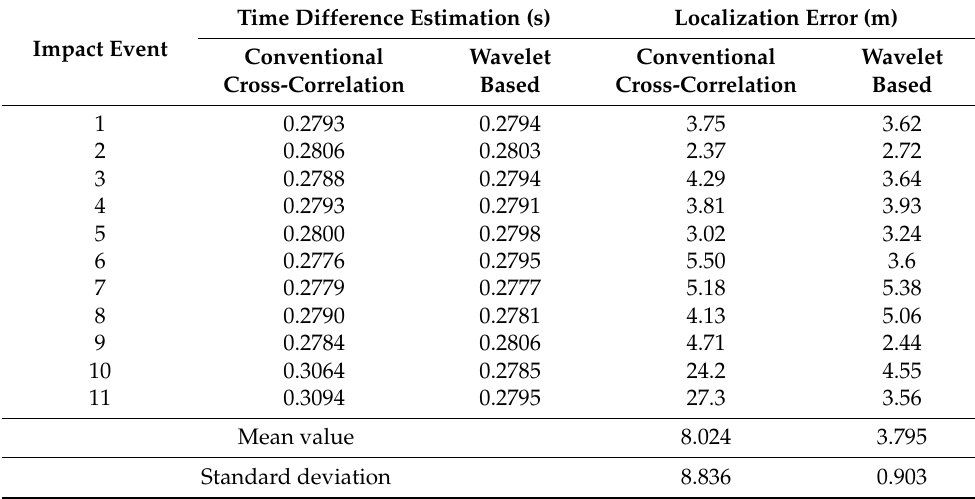
Figure 11. Wavelet − based time delay estimation with high burst noises; ( a ) vibration acceleration signal measured at S1, ( b ) vibration acceleration signal measured at S2, ( c ) CWT at S1, ( d ) CWT at S2, ( e ) time delay estimation at S1, ( f ) time delay estimation at S2. Table 3. Impact event localization Table 3. Impact event localization results.